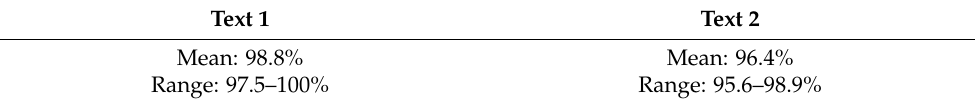
Table 1. Accuracy (means and ranges) of focus group cloze test performance.